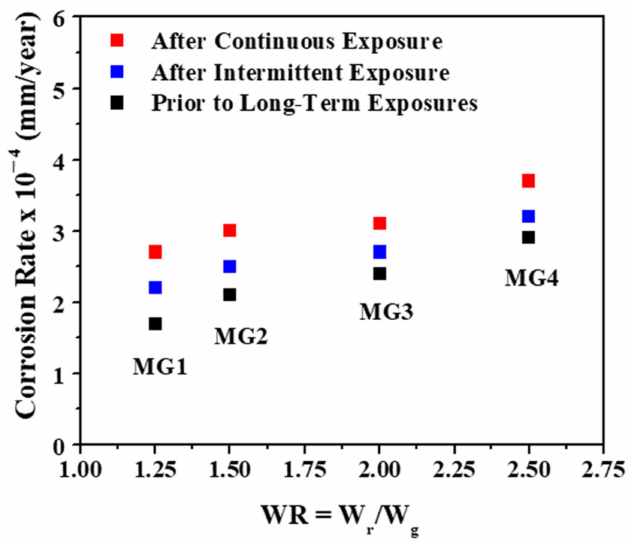
Figure 7. Corrosion rate of MG before and after long-term exposures to 3.5 wt. % NaCl solution as a function of their width ratio (WR = W r /W g ). Corrosion rate of the flat surface (mm/year) is 166 × 10 − 4 prior to long-term exposures, is 311 × 10 − 4 after intermittent exposure and is 313 × 10 − 4 after continuous exposure to NaCl solution.